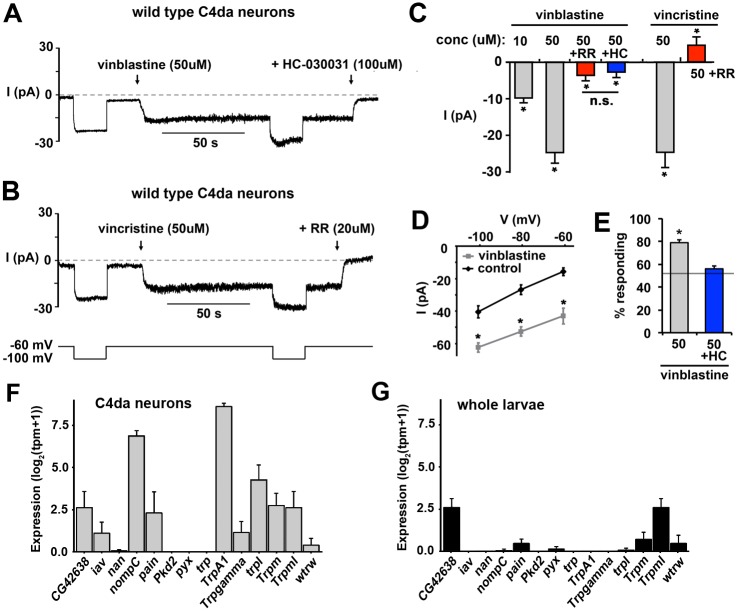
Vinca alkaloids directly excite C4da sensory neurons.A-B, Representative traces from voltage-clamped C4da neurons held at indicated voltages and challenged with 50 μM vinblastine (A) or 50 μM vincristine (B) reveal an immediate inward current that is sensitive to HC-030031 (A) and Ruthenium red (RR) (B). C, Graph represents the average values for the currents measured in voltage-clamped C4da sensory neurons resulting from the indicated treatments. * p<0.01 indicate values significantly different than all other values as determined by ANOVA. Error bars = SEM, n = 3–18 neurons per condition. D, Values represent the average current (I) obtained at each holding voltage (V) in C4da neurons exposed to vehicle (black line) or 50 uM vinblastine (gray line). *p<0.01 determined for each value by a Student’s T-test. Error bars = SEM, n = 3–4 neurons per condition. E, Graph represents the average nociceptive responses of larvae fed 50 uM Vinblastine in the absence (gray bar) or presence of 100 uM HC-030031 (blue bar). * p < 0.05 determined by Student’s T-test comparing each condition. Gray line indicates the value obtained for vehicle control larvae. Error bars = SEM, n = 160 larvae per condition. F-G, Graphs represent the average gene expression level of all transcripts of the indicated Drosophila TRP family genes in purified C4da neurons (F; gray bars) and in whole larvae (G; black bars). tpm = transcripts per million. Error bars = sem. n = 4 independent samples for each condition.